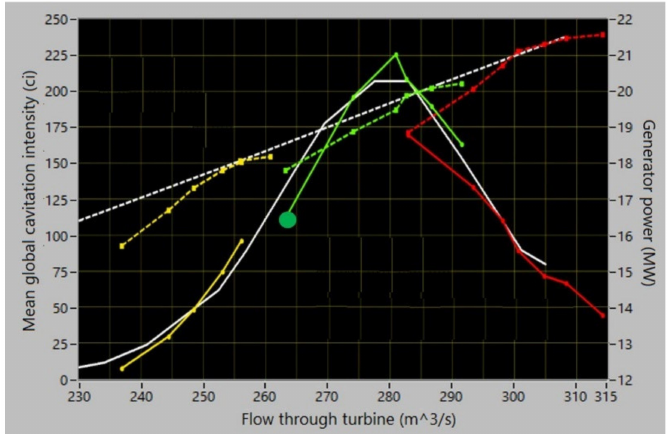
Figure 13. Cam check based on relative efficiency: white – on cam, coloured – off cam; solid lines – cavitation intensity I (